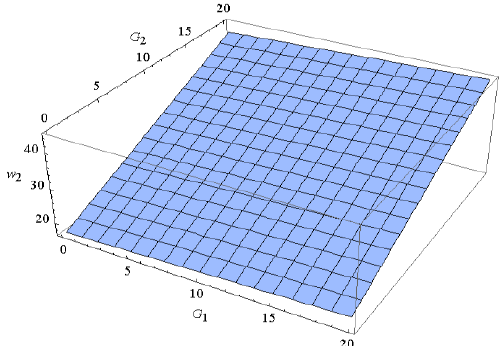
Figure 6. The impact of competitive product goodwill on the wholesale price of Product 2.